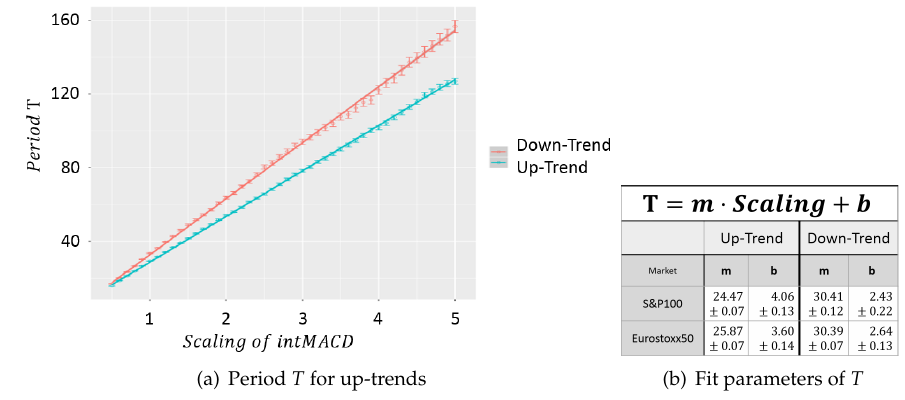
Figure 12. Evolution of the period T for scalings between 0.5 and five with a step size of 0.1 for S&P100 stocks. ( a ) period T for up-trends. ( b ) Fit parameters of T